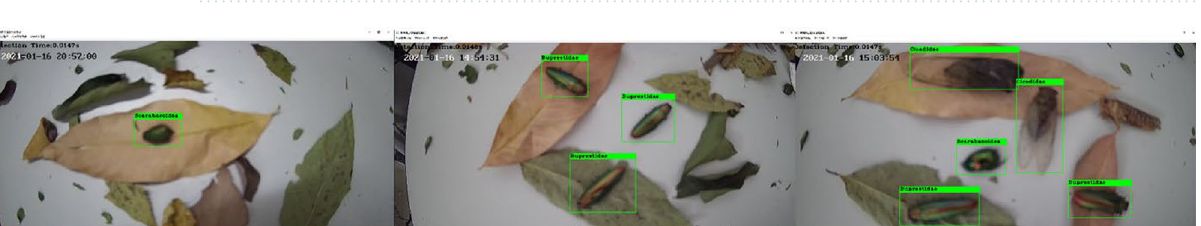
Figure 17. Test results in the laboratory with wired camera. Note : The first picture was a test result with a single insect, the second picture was a test result with insects and the third picture was a test result with multi-type insects.